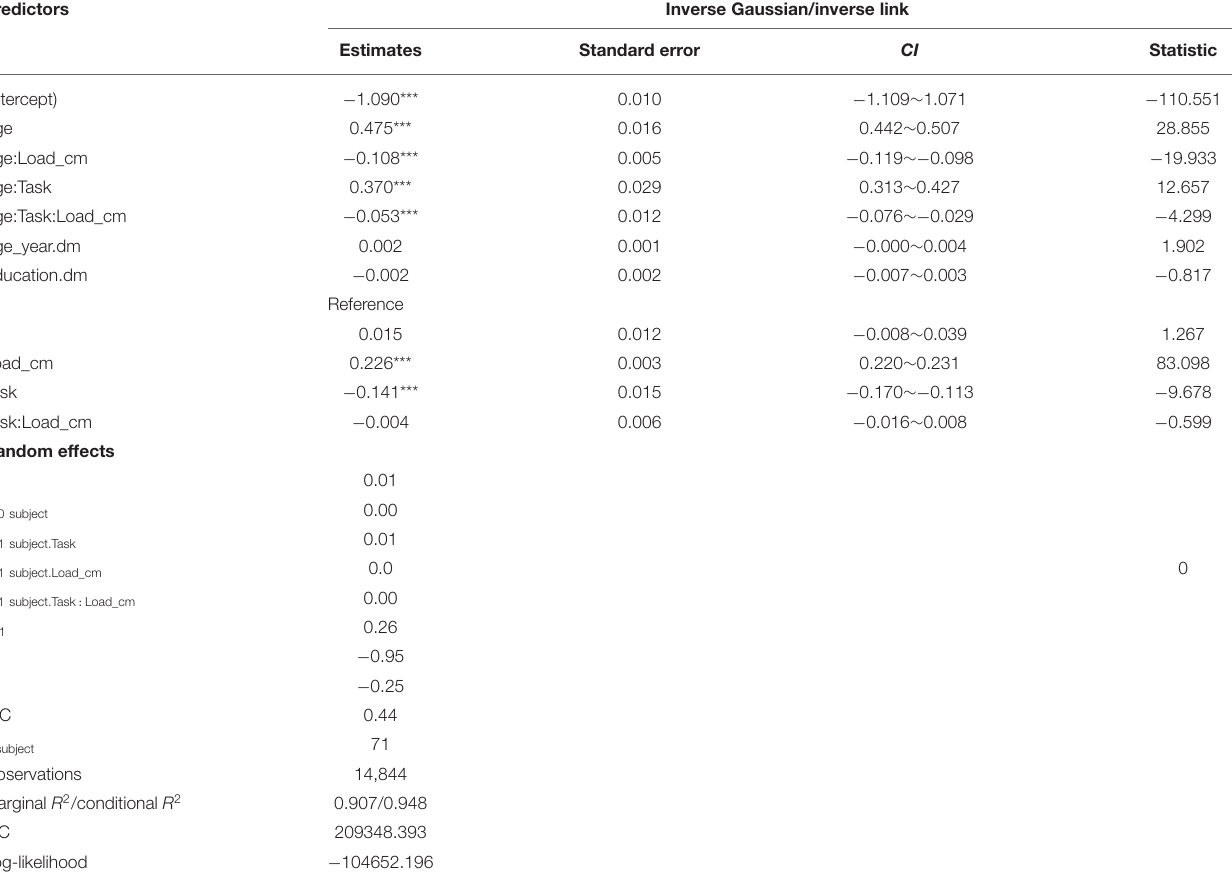
TABLE 2 | Summary table of the final GLMM.